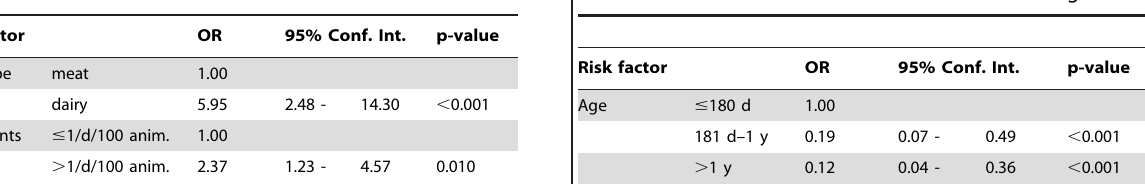
Table 4. Animal level risk factors for ESBL